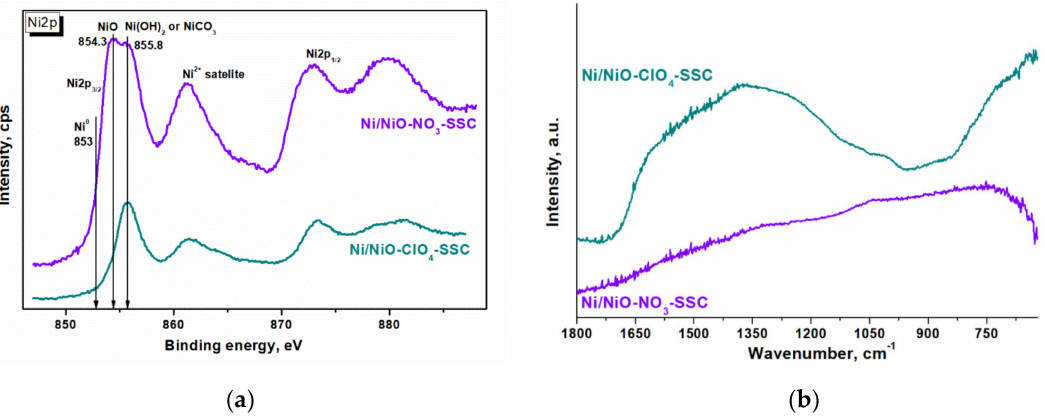
Figure 8. ( a ) XPS and ( b ) ATR FTIR spectra for Ni/NiO-NO 3 -SSC and Ni/NiO-ClO 4 -SSC samples.